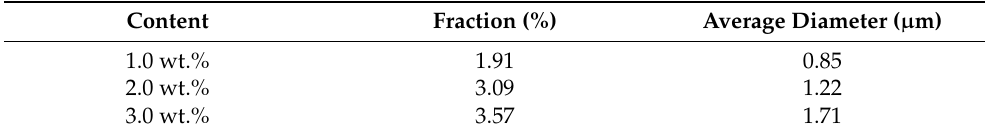
Figure 3. Distribution of TiC particle in the matrix of medium chromium cast iron with different Ti contents. Table 2. Fraction and average diameter of TiC with different Ti 3 AlC 2 additives.